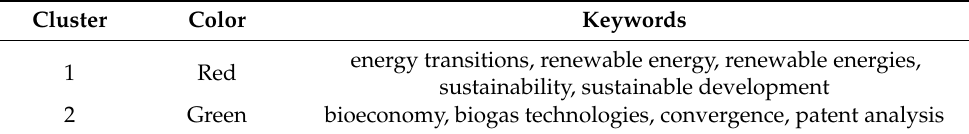
Figure 9. Bibliometric map of all keyword co-occurrence results from Scopus based on Query 21. Source: authors’ elaboration performed in VOSviewer (version 1.6.18). Table 9. Clusters of keyword co-occurrences in Figure 9 for Scopus Query Table 9. Clusters of keyword co-occurrences in Figure 9 for Scopus Query 21.